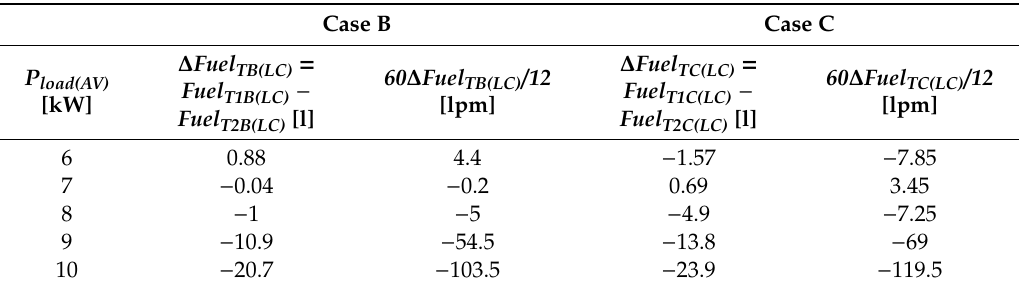
Table 6. ∆ Fuel T for the Air-LFW and Fuel-LFW strategies (Cases B and C, same P RES , and di ff erent P load ( AV )